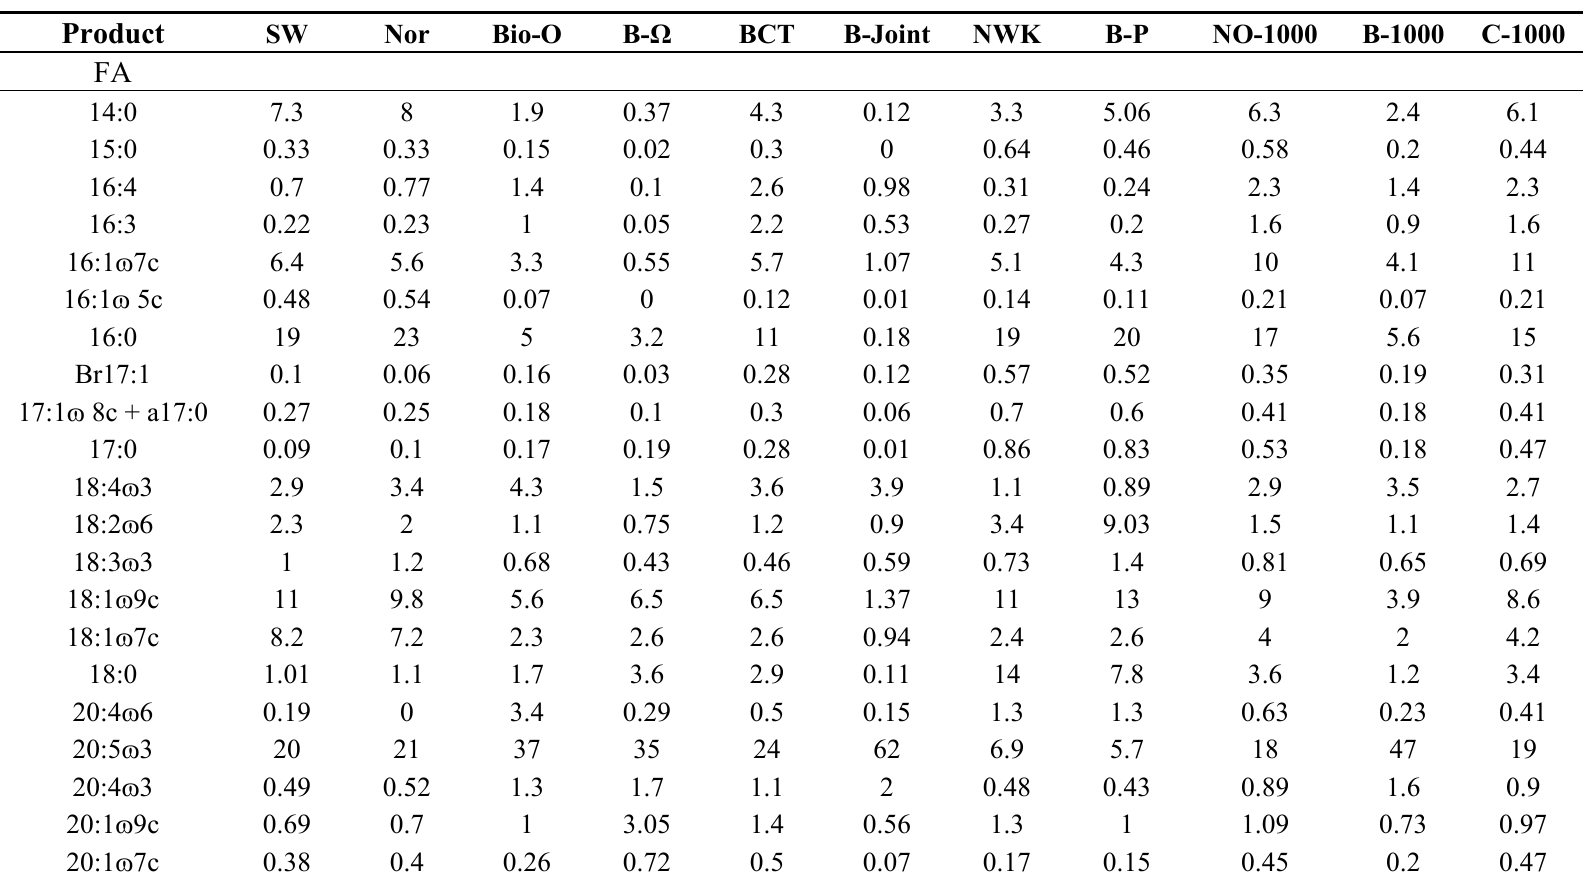
Table 2. A catalogue of fatty acids (FA) quantified, together with the composition (as percent of total FA) of all products. Abbreviations used for oil products are: Swisse Krill Oil (SW); Norkrill (Nor); Bio-organics (Bio-O); Blackmores Omega (B- Ω ); Bioceuticals (BCT); Blackmores Joint (B-Joint); Nature’s Way Kidsmart (NWK); Blackmores Pregnancy (B-P); Nature’s Own 1000 mg (NO-1000); Blackmore’s 1000 mg (B-1000); Cenovis 1000 mg (C-1000). Capsules or subsamples from two separate batches of each product were pooled for each FA analysis, except for Blackmores Omega Liquid Fish Oil for which only a single batch number could be sourced. Other: denotes FA present at <0.5% in all